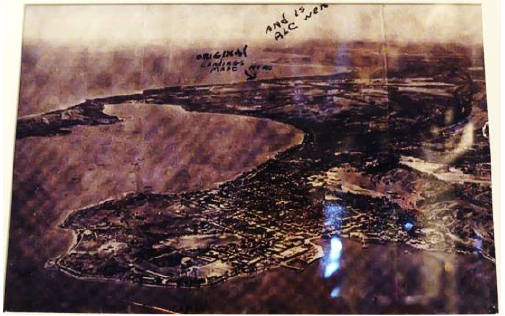
Figure 11. Vintage aerial photograph of Tacloban City displayed in Hotel Alejandrino. A pond can be clearly seen in the moddle of Tacloban City.